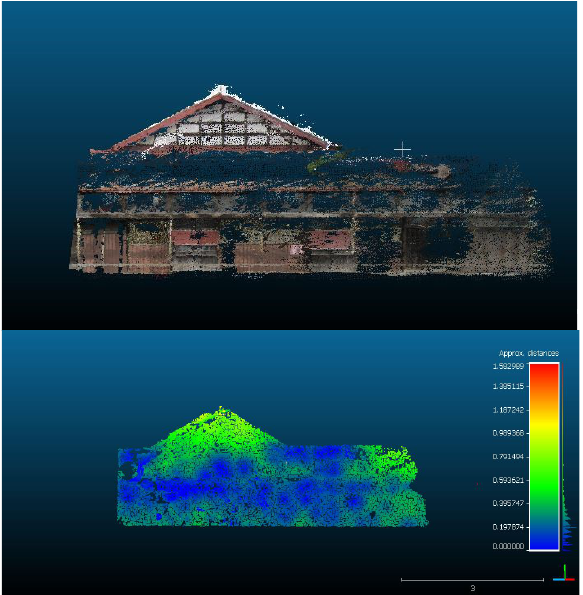
Figure 10. Cloud to cloud distance for the Former Matsuno-Yu building.